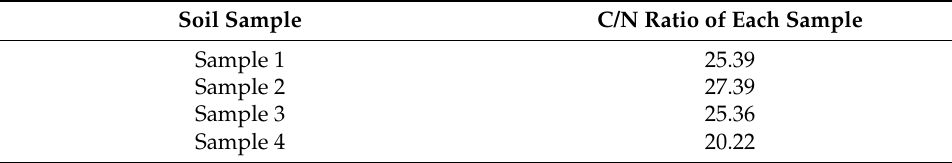
Table 3. C/N ratio of each soil sample after 21 days decomposition of bokashi.